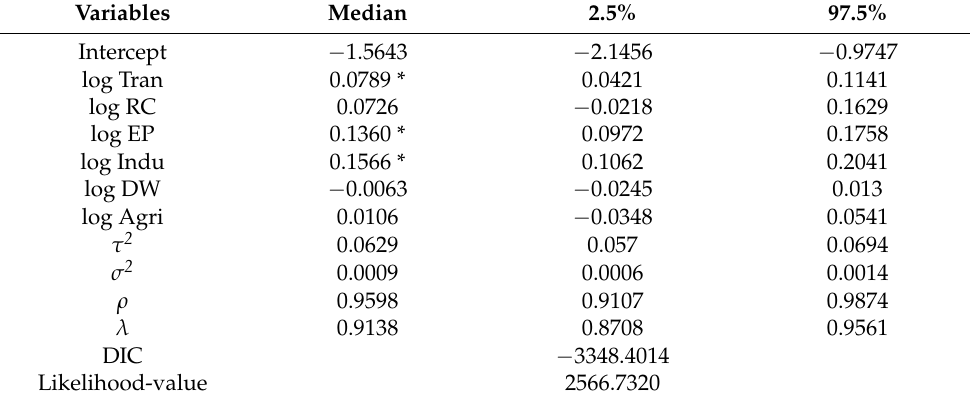
Table 2. Model 1 estimation results.